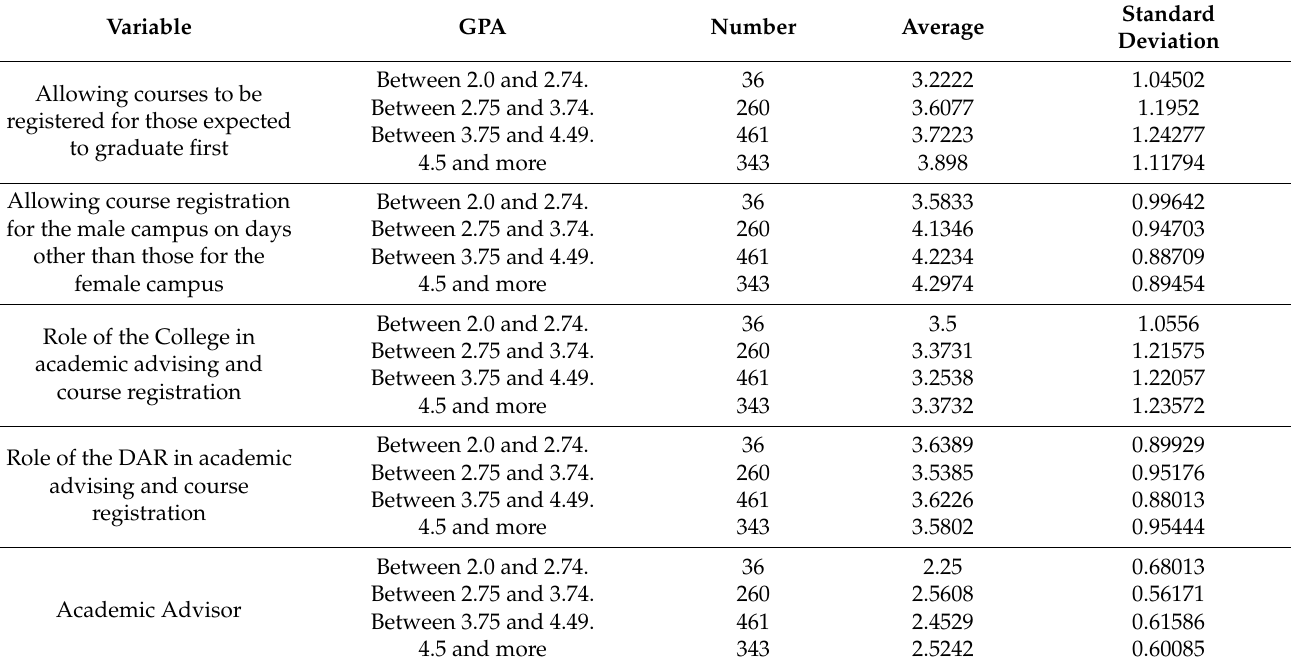
Table 22. Descriptive statistics of study variables by